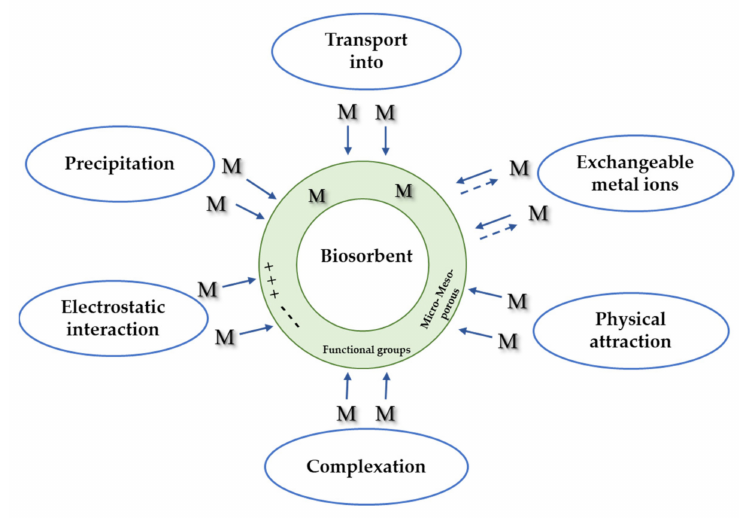
Figure 2. Possible mechanisms of metal